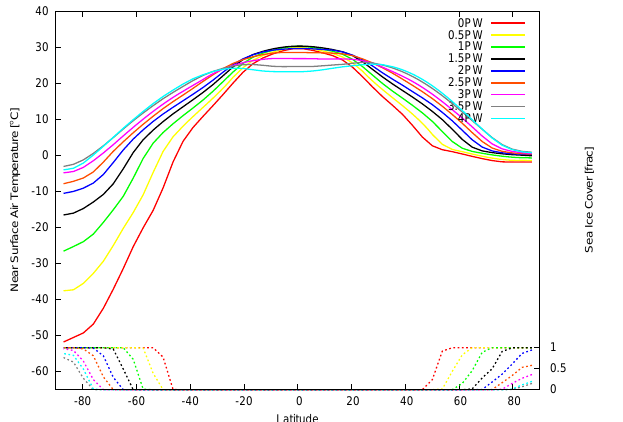
Figure 3. Climatological Northern Hemisphere summer (June– August) averages for all simulations: zonal mean near-surface tem- peratures (in ◦ C; solid lines) and sea-ice cover (dotted